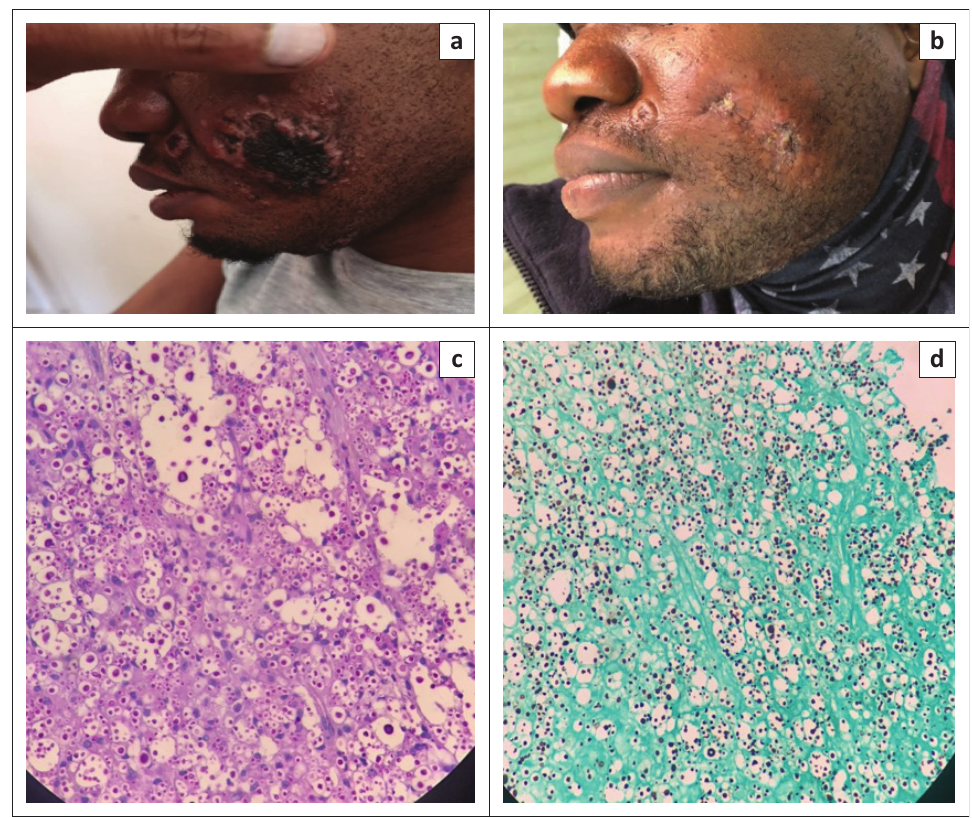
FIGURE 1: (a) A 4-cm, centrally necrotic plaque on the patient’s left cheek with a smaller papule adjacent to it; (b) significant improvement of the same lesions following 5 weeks of therapy; (c) periodic acid–Schiff and (d) Grocott–Gomori stained sections showing numerous fungal organisms with a large clear capsule, in keeping with Cryptococcus neoformans (original magnification,